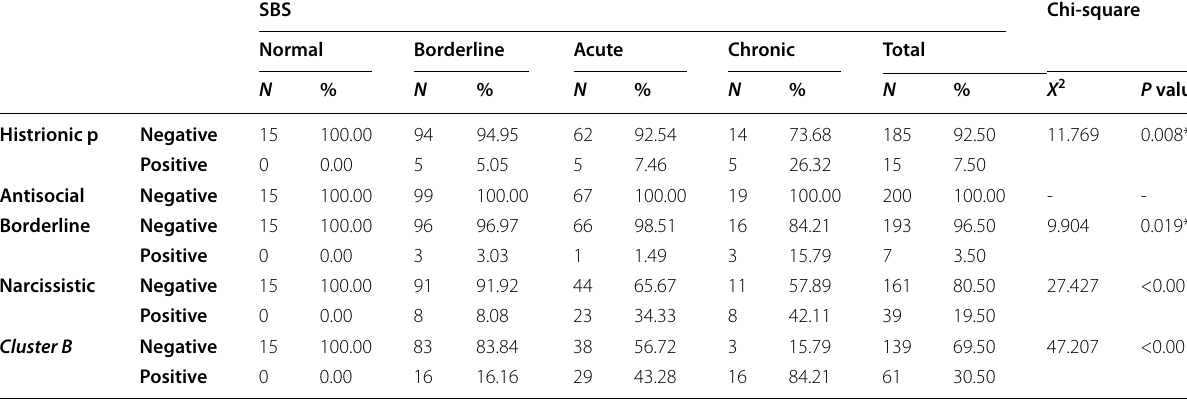
*significant result Table 6 relationship between personality disorders and levels of SELFIE